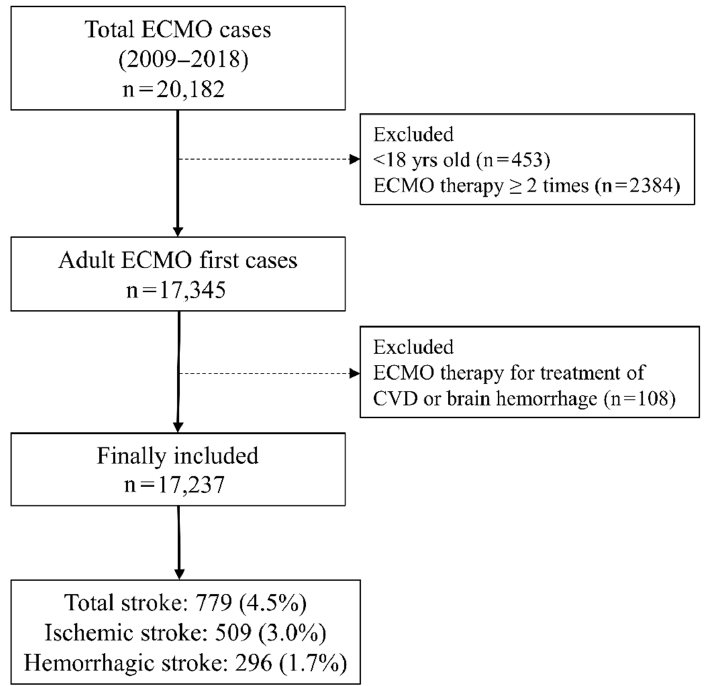
Figure 1. Flowchart depicting the patient selection process. ECMO, extracorporeal membrane oxygenation; CVD, cardiovascular